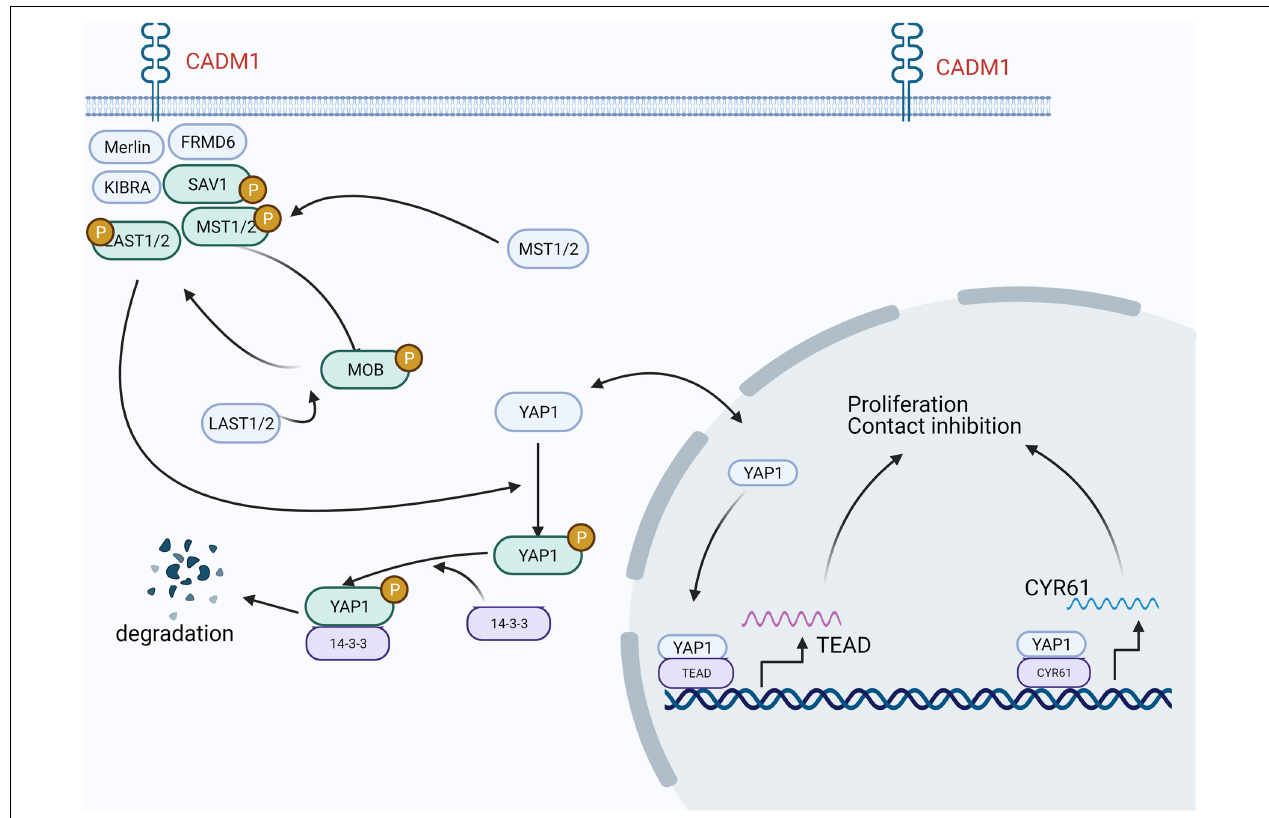
FIGURE 1 | In lung adenocarcinoma, CADM1 participates in the Hippo pathway, thereby regulating cell proliferation and contact inhibition. CADM1 forms a scaffold protein complex with NF2, KIBRA, SAV1, etc., recruits MST1/2 and LATS1/2 kinases to the cell membrane to activate the Hippo pathway, and then moves to the cytoplasm or nucleus after phosphorylation to inactivate YAP1 and inhibit the transcription of its target genes, thereby inhibiting cell